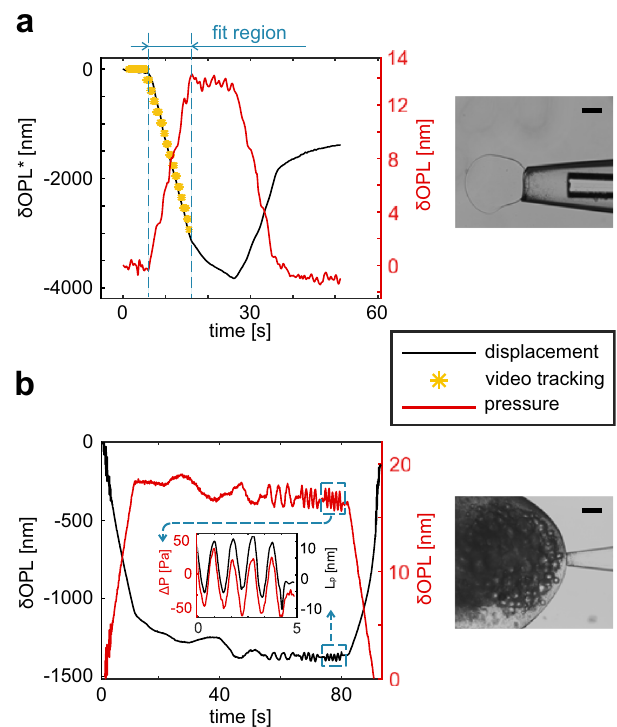
Fig. 2 System validation. a Quasi-static aspiration of an alginate bead. The plot shows the variation of the phase of the cavities associated with the pressure sensor (red line) and the displacement sensor (black line). Since a negative pressure is applied, the fi ber to sample distance is reducing while the pressure sensor cavity is increasing. To compare the fi ber-to-bead cavity variation with the video tracking, the displacement measurement ( δ OPL*) is corrected by dividing it by the refractive index of water ( n = 1.331). The membrane displacement is represented with yellow asterisks. b DMA on a fl ying fi sh roe, with a highlight on one of the test frequencies (red line for pressure, black line for aspirated length). Images of the alginate bead and the fl ying fi sh roe captured by the measurement probe are shown in the right column. Scale bars are 100 µ system. An example of the experimental results is given in Fig. 2b. The elastic modulus of the fi sh eggs was calculated to be 360 ± 50 kPa, with N = 10.